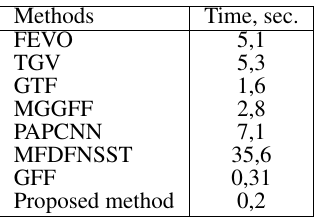
Table 1. Comparison image fusion methods by computation time based on the probabilistic gamma-normal model does not give a smoothing effect during fusion of original images. MI and Q AB/F metrics do not give the best results due to the poor quality of original images, which leads to distortion of objects boundaries in original